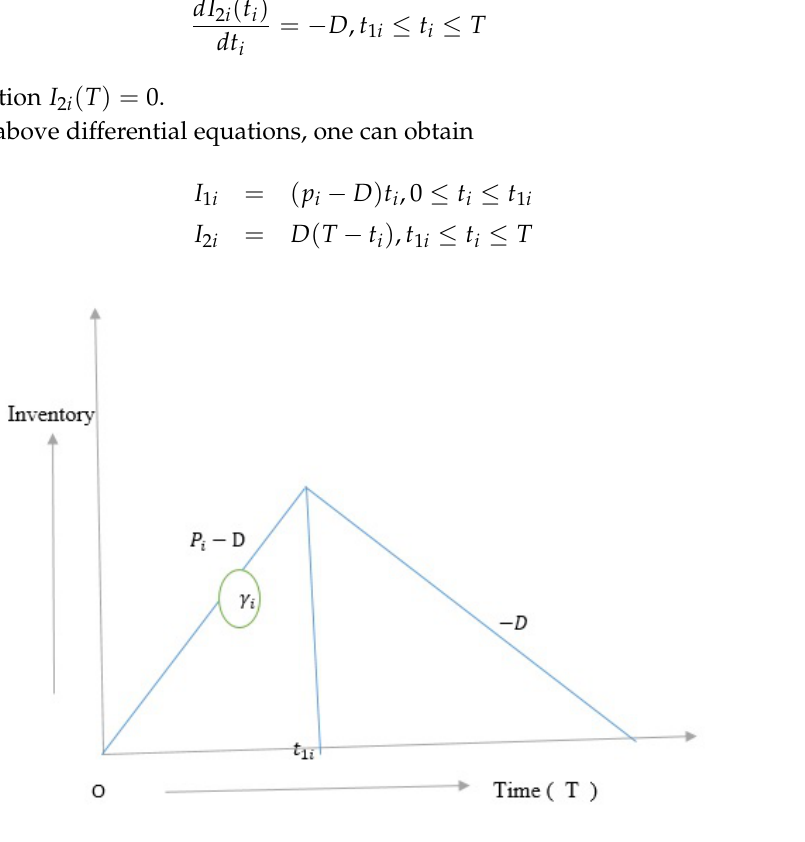
Figure 2. Economic Production